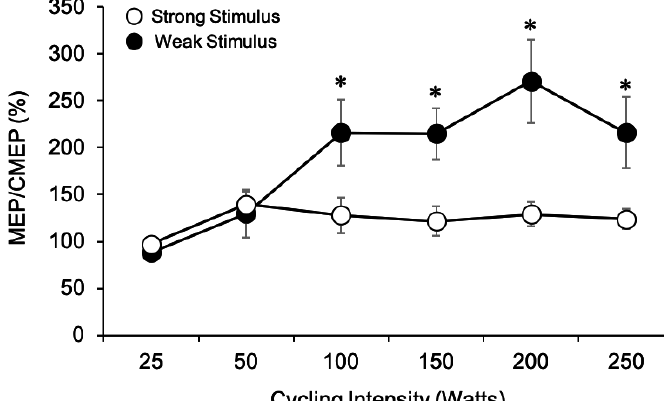
Figure 4. Comparison of MEP/CMEP ratios for the weak (filled circles) and strong (unfilled circles) stimulation intensities as power output increased from 25 W to 250 W. * represents significant difference between stimulation intensities at each given power output ( p < 0.05). In some cases, SE bars were smaller than the symbols for the data